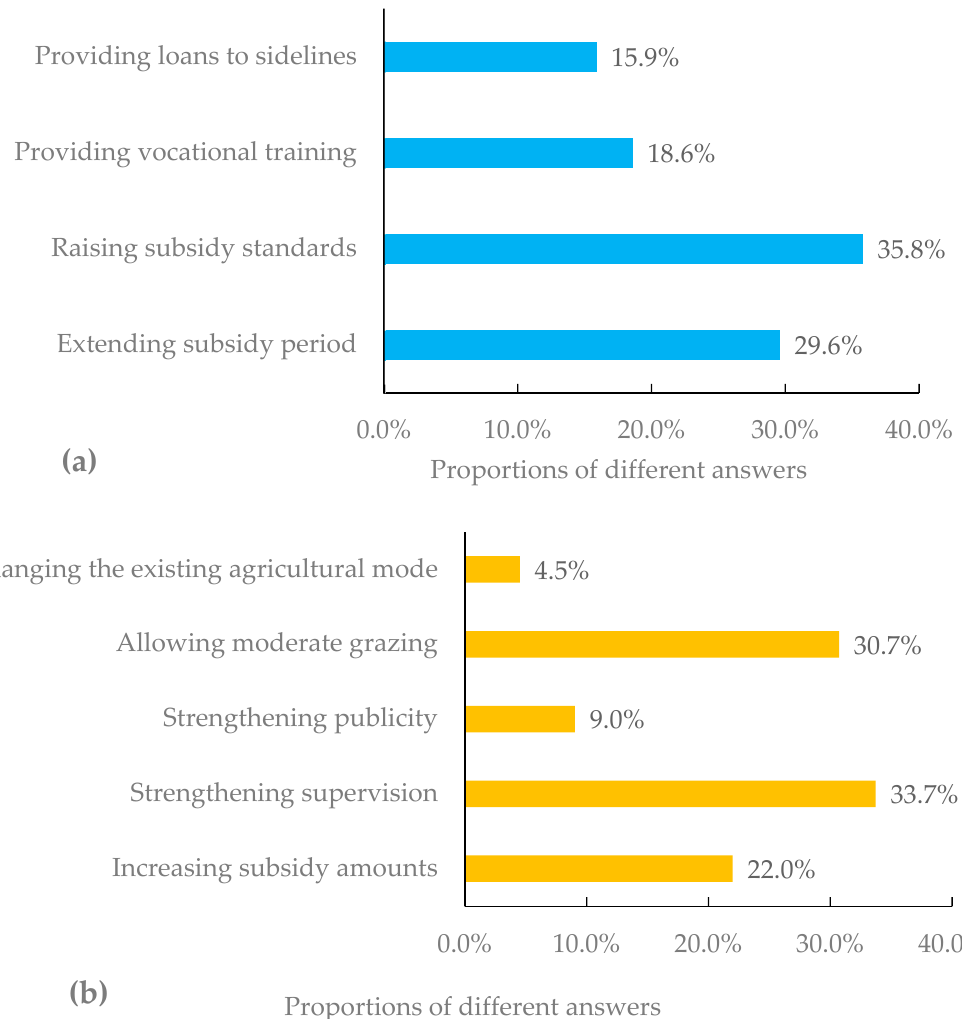
Figure 3. Farmers’ suggestions about the DCPs: ( a ) suggestions for adjusting subsidy policy; ( b ) suggestions for regulating illegal grazing.